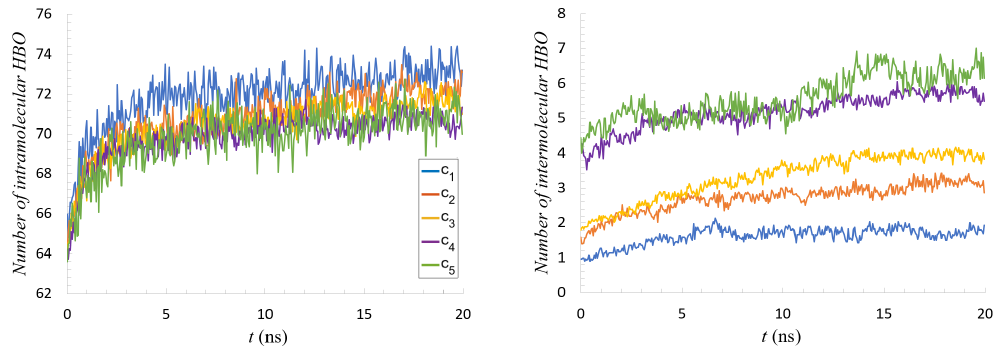
Figure 6. Number of hydrogen bonds per single mucin molecule. Two cases are presented: ( left ) intramolecular; ( right )